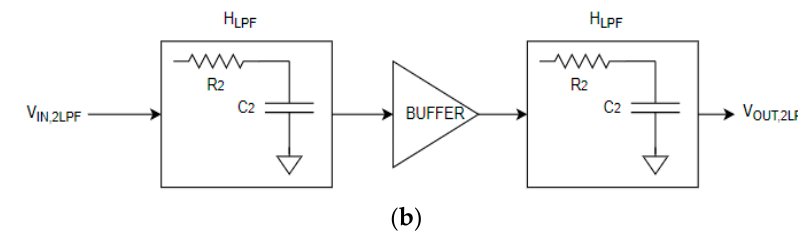
Figure 11. First and second order low pass filters: ( a ) first order passive filter schematic; ( b ) second order active low pass filter concept.